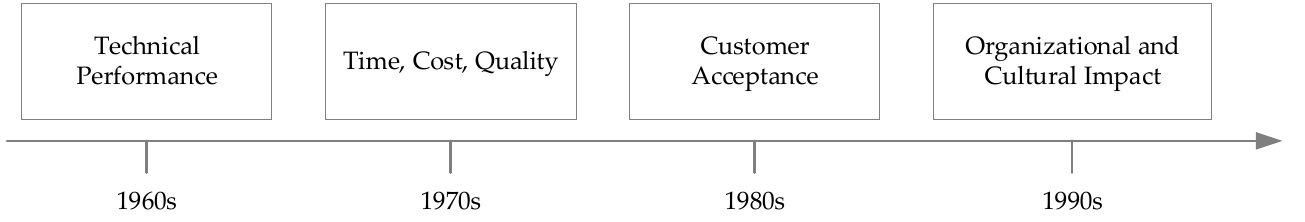
Figure 1. Historical Success Definitions, based on O'Brochta [20].